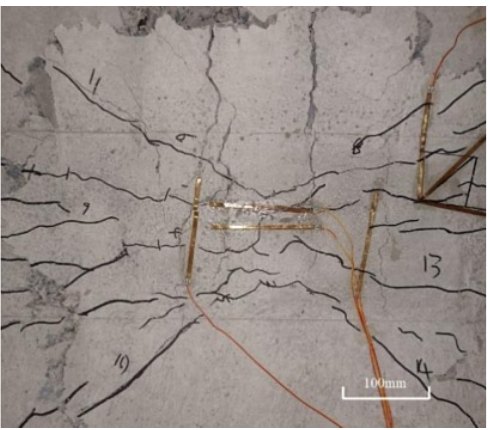
Figure 15. The damage mode at the slab bottom of P1 under static